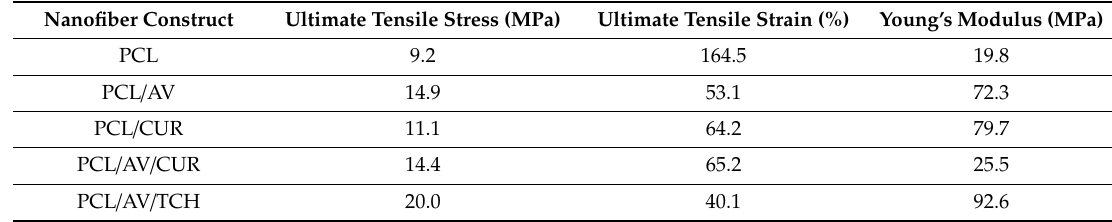
Figure 3. Tensile properties of PCL, PCL/AV, PCL/CUR, PCL/AV/CUR and PCL/AV/TCH nanofibrous scaffolds. Table 2. Mechanical properties of various electrospun nanofibrous scaffold. Table 2. Mechanical properties of various electrospun nanofibrous sca ff old.